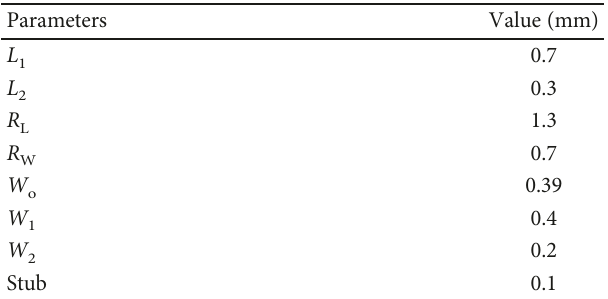
Figure 4: Geometric design of the single-section-modi fi ed WPD. Table 3: Optimized parameters of the single-section-modi fi ed Wilkinson power divider with ports matched to 50 Ω